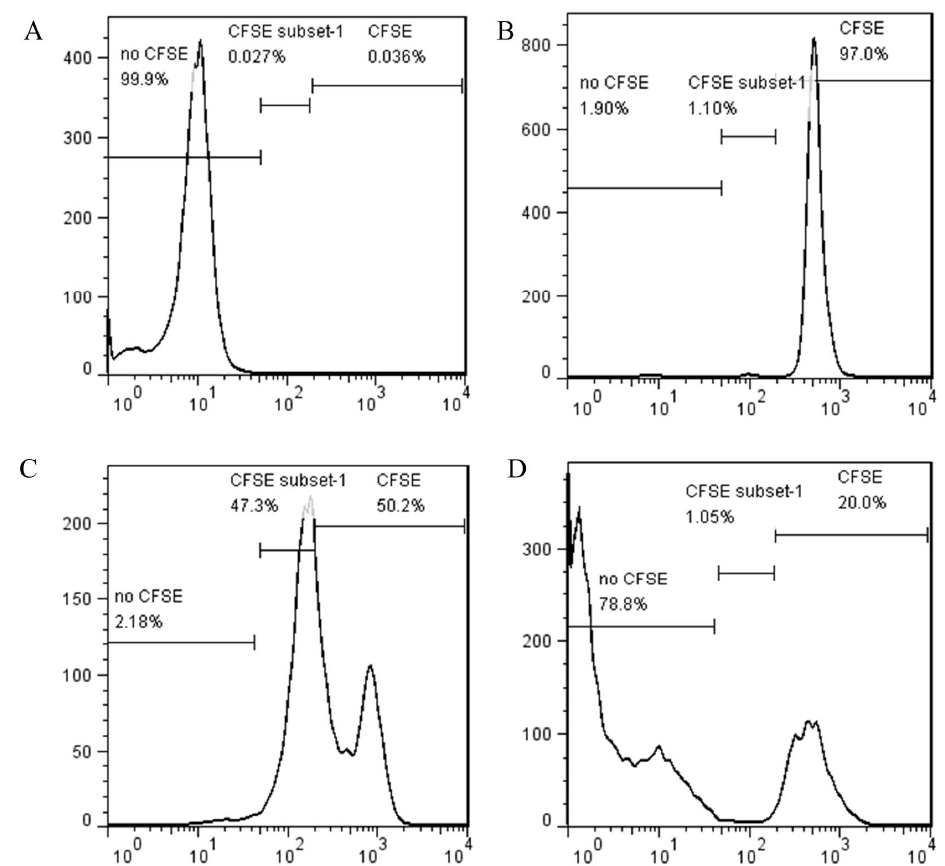
Figure 1. CD4 + CD25 + cells suppress the proliferation of naive T cells : ( A ) negative control: CD4 + CD25 − cells with no CFSE staining; ( B ) positive control: CD4 + CD25 − cells with CFSE staining; ( C ) ConA-stimulated CD4 + CD25 − cells; ( D ) coculture of ConA-stimulated CD4 + CD25 − cells with CD4 + CD25 + cells at a ratio of 1:1. CFSE dilution of CFSE-labeled CD4 + CD25 − cells was measured at 66 h of coculture after gating on CFSE-stained cells. Three gates mean: no CFSE, the percentage of CFSE negative cells; CFSE, the percentage of no-proliferative CFSE positive cells; CFSE subset-1, the percentage of proliferative CFSE positive cell. n = 3, results are representative of two independent experiments.